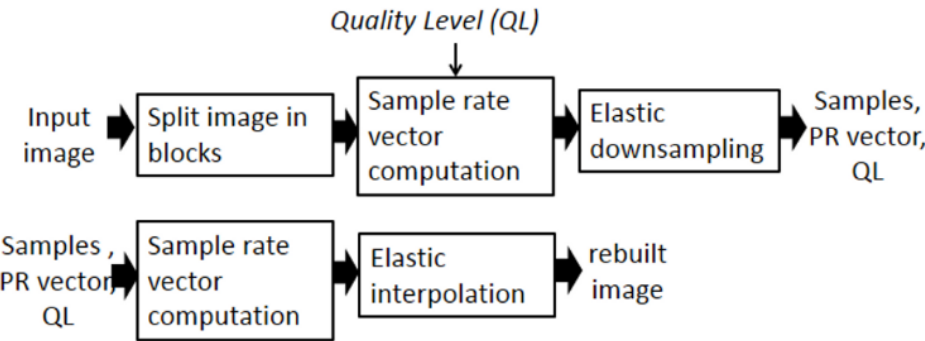
Figure 2. Elastic downsampling diagram.